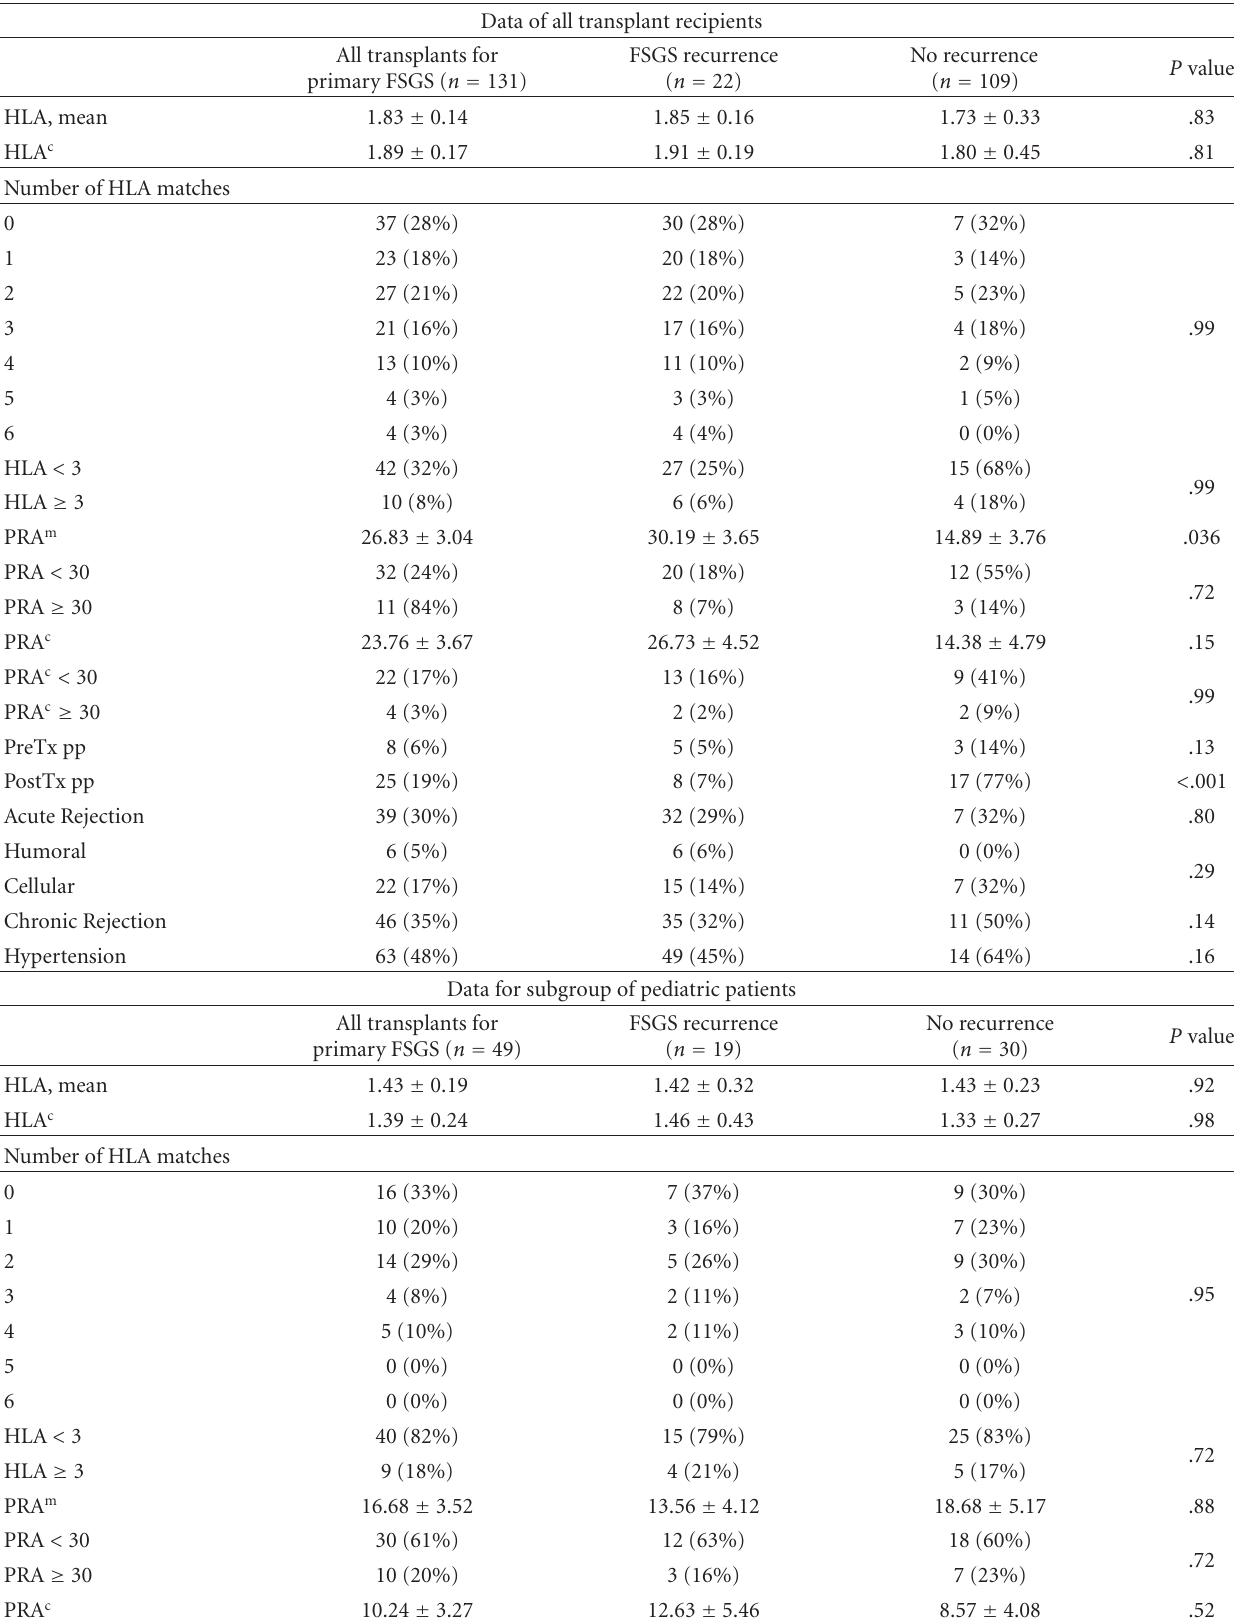
Table 3: Recurrent Focal Segmental Glomerulosclerosis in renal allograft recipients from 1990 to 2007 at Montefiore Medical